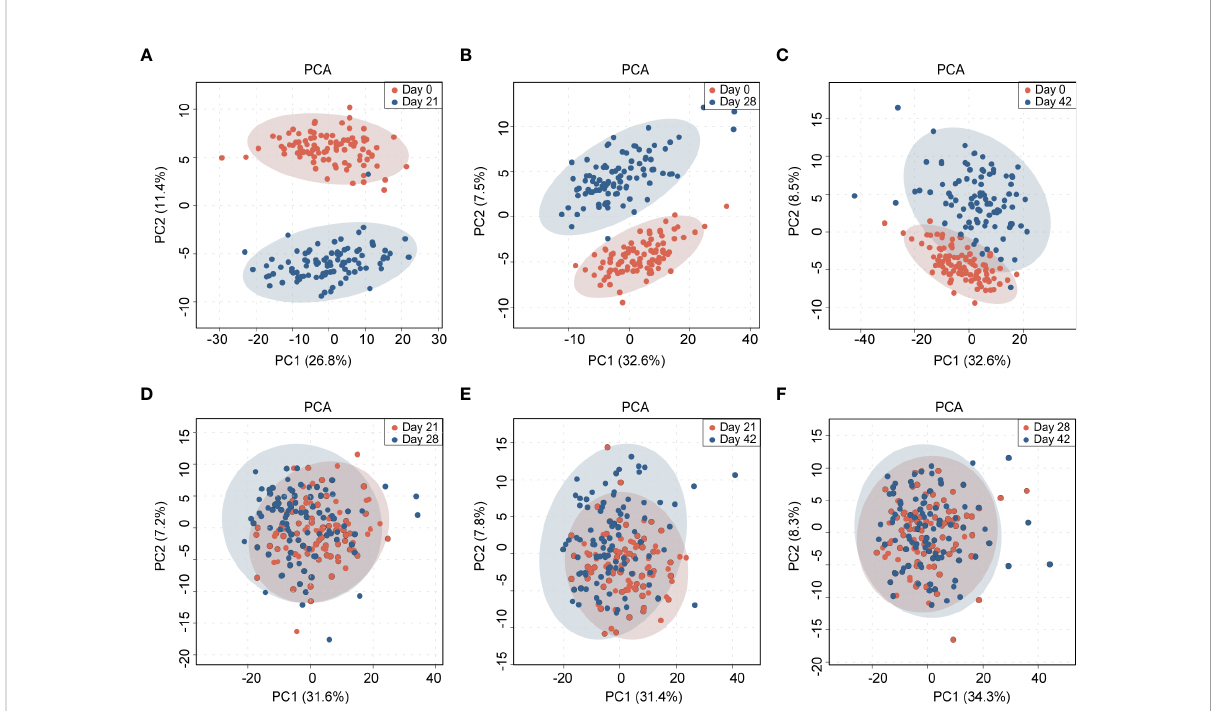
FIGURE 3 Principal component analysis (PCA) of the MALDI-TOF MS-based serum peptidome pro fi les collected at 4 timepoints beforeand aftervaccination: (A) between day 0 and day 21; (B) between day 0 andday 28; (C) betweenday 0 and day 42; (D) between day 21and day 28; (E) between day 21and day 42; (F) between day 28andday 42. The shadow ovals represent 95%con fi